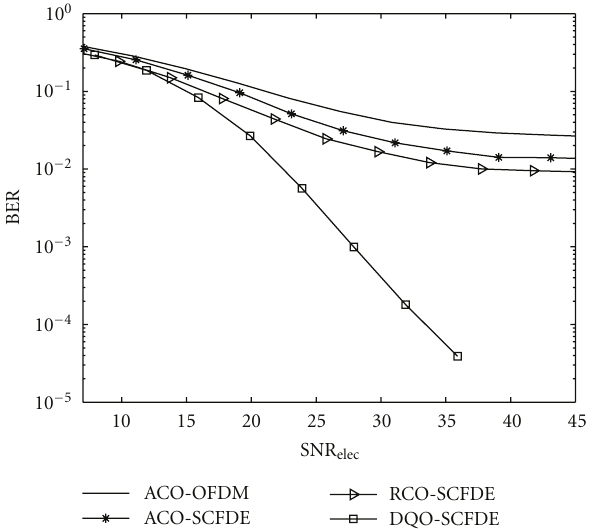
Figure 15: MMSE BER comparison of ACO-OFDM, ACO-SCFDE, RCO-SCFDE, and DQO-SCFDE with N = 64, 16 QAM input symbols with average power 0.1 W, L =